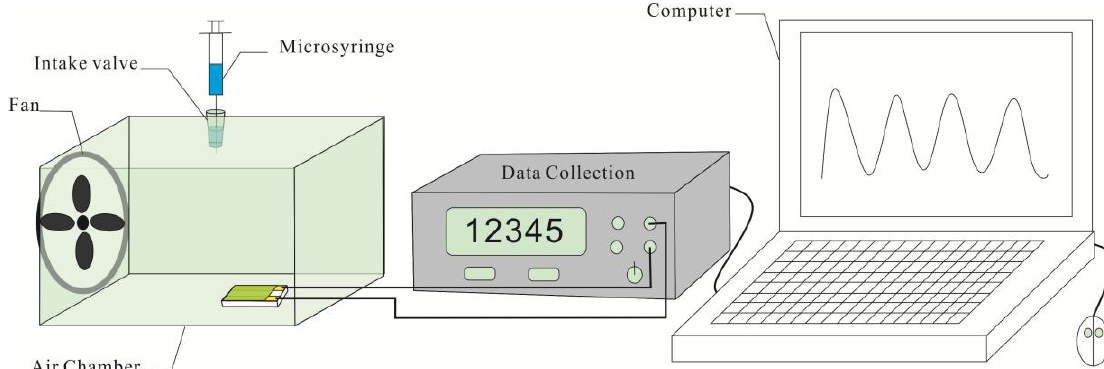
Figure 1. Schematic illustration of home-made gas sensing system.